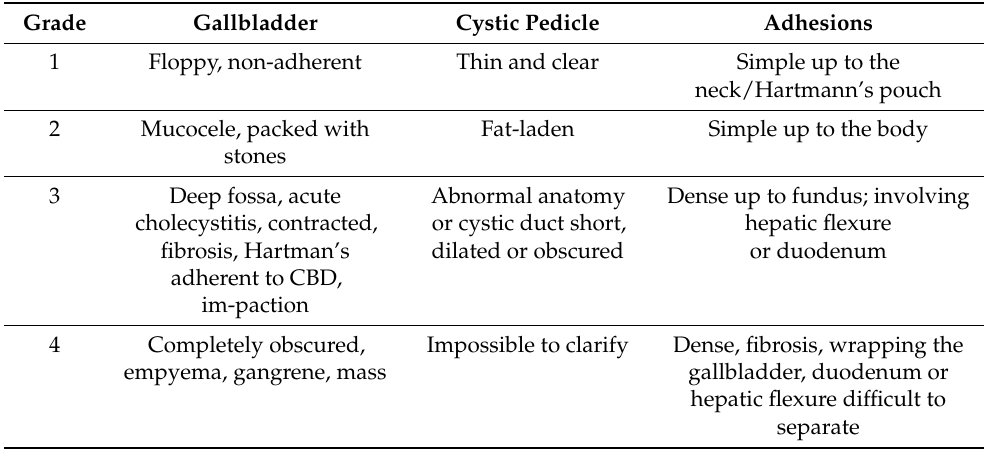
Table 6. Nassar grading scale for operative findings from the gallbladder, cystic pedicle and associated